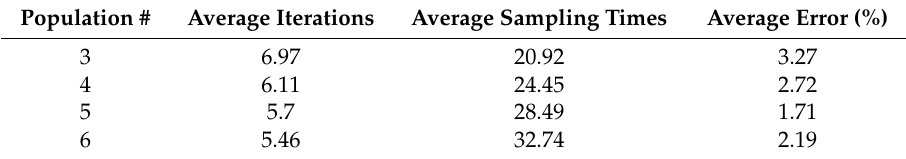
Table 5. Simulation results of the FA with different population numbers under the 10 patterns.